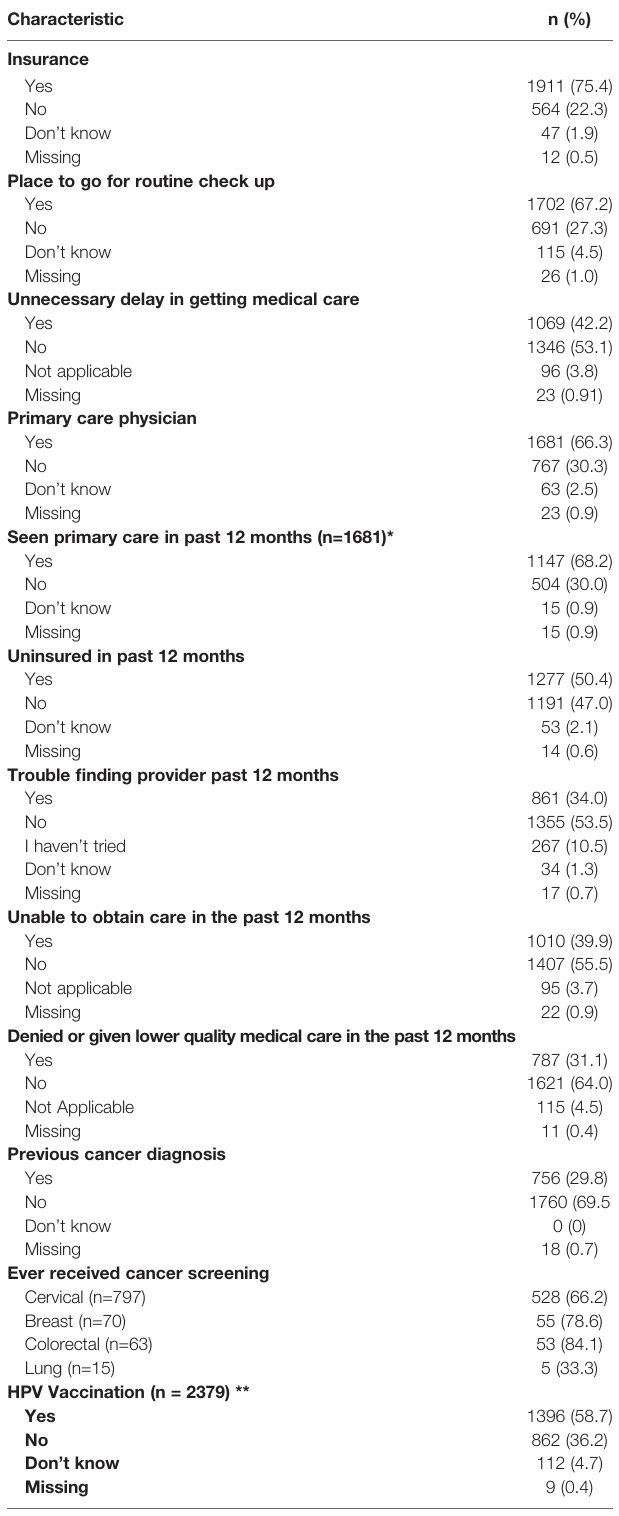
TABLE 4 | Characteristics of the population in terms of access to care and cancer prevention practices.